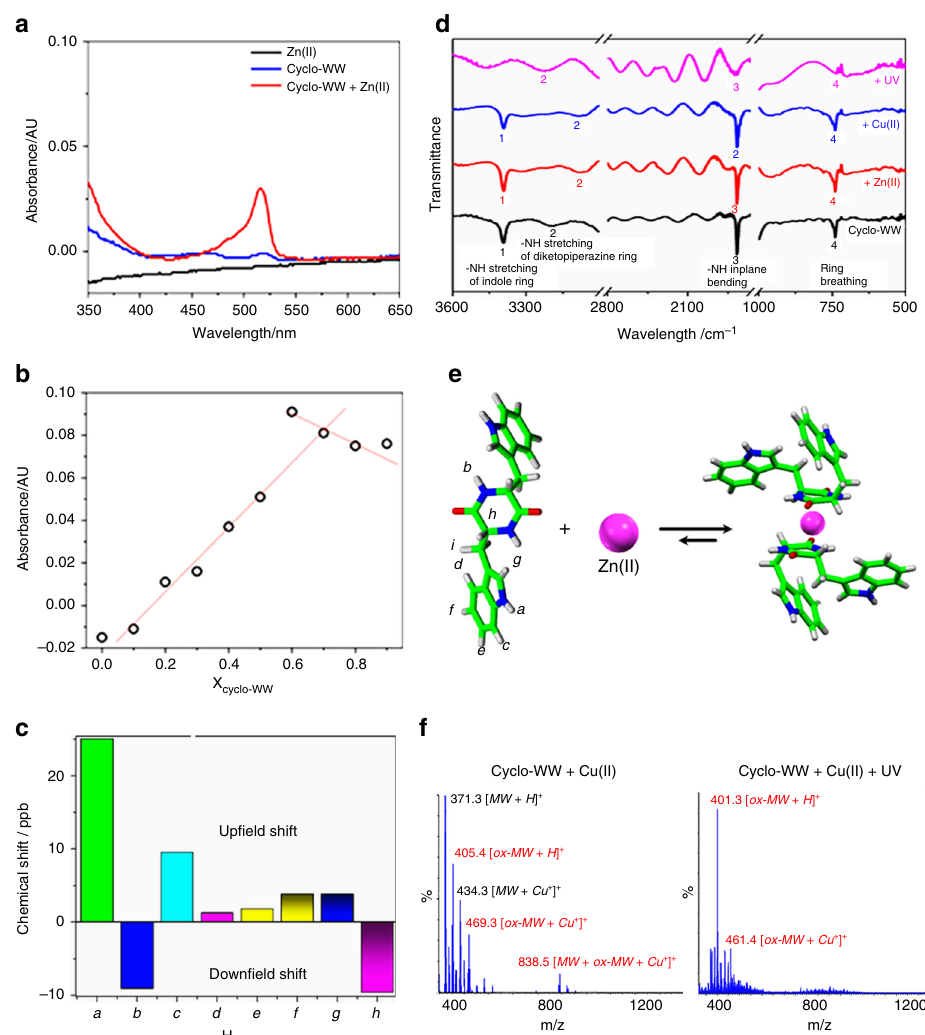
Fig. 4 Mechanisms underlying fl uorescence modulation. a UV-Vis absorption spectra of cyclo-WW self-assemblies in the absence or presence of Zn(II) in MeOH. A peak at 515 nm appeared when complexing cyclo-WW and Zn(II). b Job Plot analysis of cyclo-WW with Zn(II) at different ratios, with the total molar concentration fi xed at 15.0 mM. The red lines were added for guideline, showing the intersection point at cyclo-WW proportion of 0.7. c Chemical shifts of cyclo-WW hydrogen atoms upon coordination with Zn(II), compared to the peptide alone. The hydrogen atoms in different chemical environments are marked with italicized letters and labeled in e . d FTIR spectra of cyclo-WW self-assemblies in the absence or presence of metal ion/UV irradiation. The peaks of the active bonds are numerically marked. Note that the IR spectra were vertically moved for clarity. e Schematic presentation showing the possible molecular mechanism of cyclo-WW dimer coordination with Zn(II): the backbone diketopiperazine rings contribute to the complexation through nitrogen atoms, while the side-chain indole rings form aromatic interactions. f MS spectra of cyclo-WW + Cu(II) and cyclo-WW + Cu(II) + UV, showing the MW of oxidized cyclo-WW (marked in red) and reduced Cu(I), con fi rming the redox reactions in the